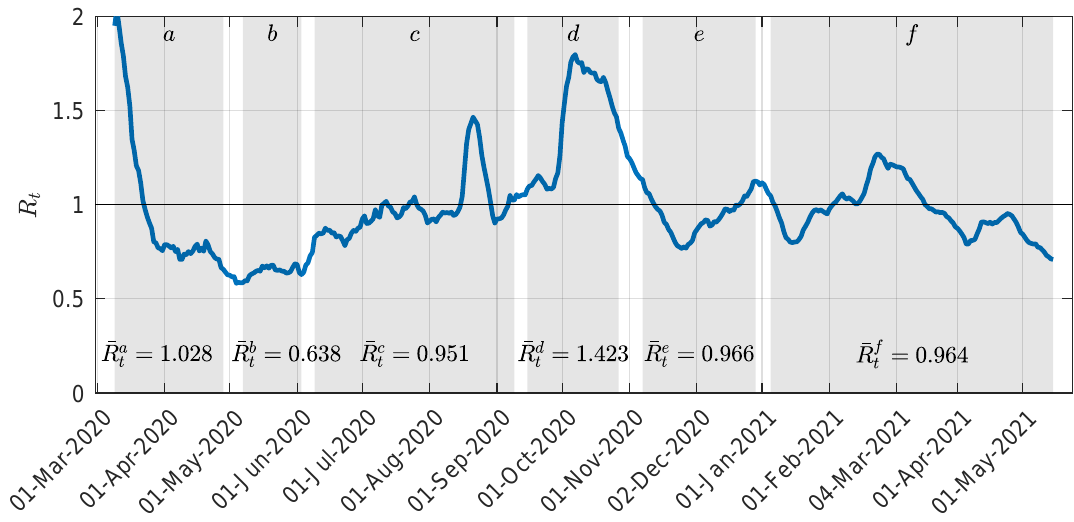
Figure 2. National reproduction number R t within the considered time windows. Each shaded portion of the plane corresponds to a specific scenario. The mean value ¯ R i window i ∈ { a , . . . , f } is reported at the bottom of each shaded region.